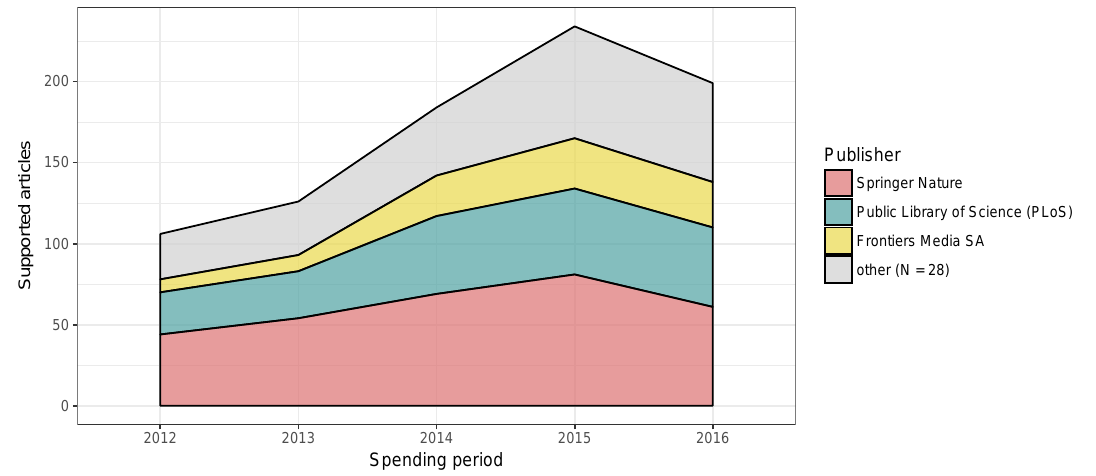
Figure 1. Articles (co-)funded by SUB Göttingen’s Open Access Fund. Data source: https://github.